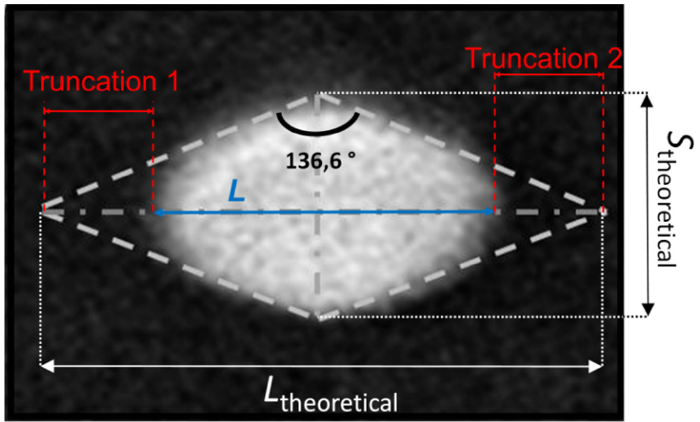
Figure 12. Example of a TiO 2 NP oriented ② as imaged with SEM with an illustration of the expected theoretical bipyramidal structure marked in dashed lines.